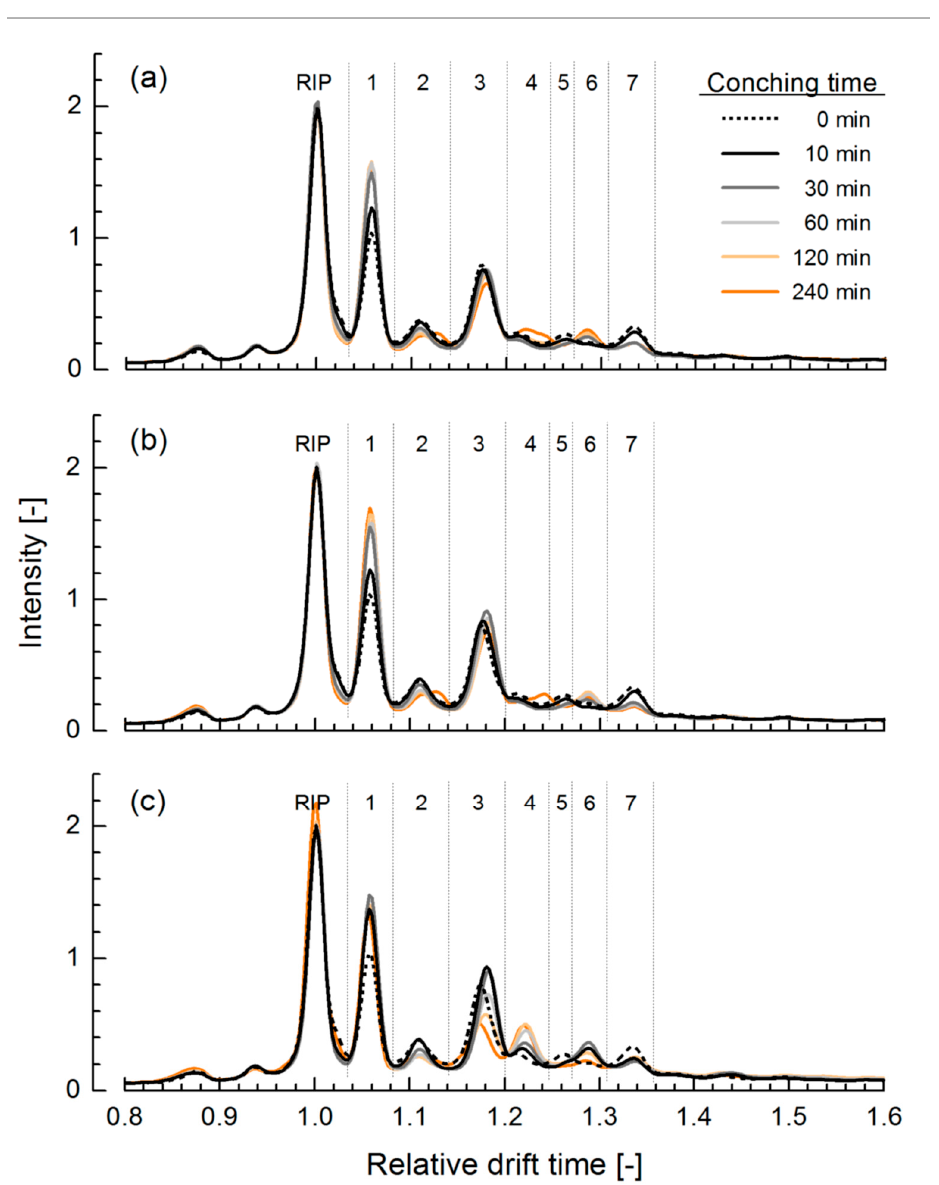
Figure 1. Ion mobility (IM) spectra of dark chocolate mass, conched in duplicate at 50 ◦ C ( a , b ) and 75 ◦ C (( c ), only one trial shown) as a function of conching time. Dashed lines and the indicator “0 min” refer to the chocolate mass before conching. RIP: reactant ion peak.